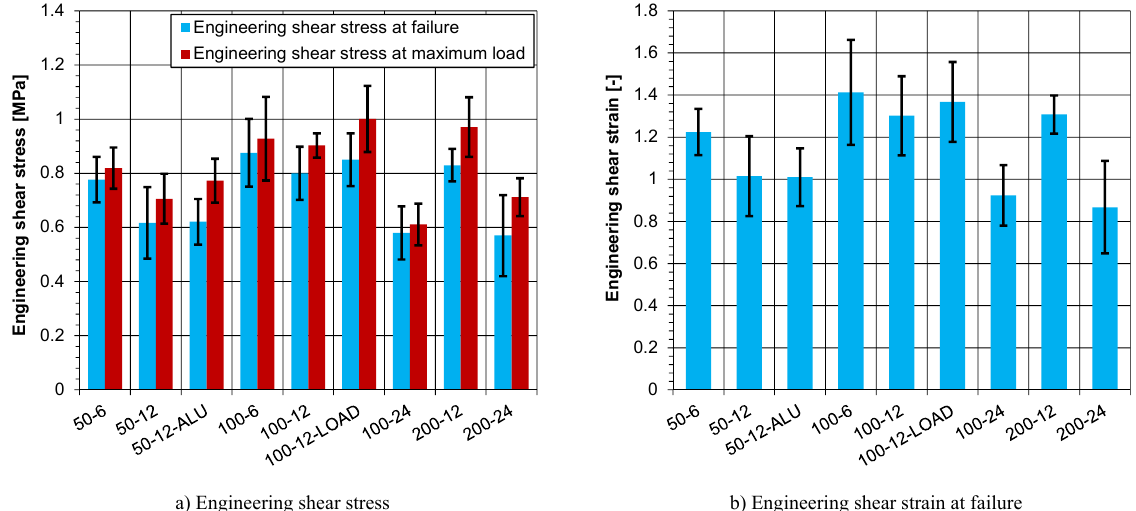
Fig. 12 Engineering shear stresses and strains for the failure point (appearance of a significant crack) and engineering shear stresses at the maximum load level. The average value and the standard deviation are given for each series.